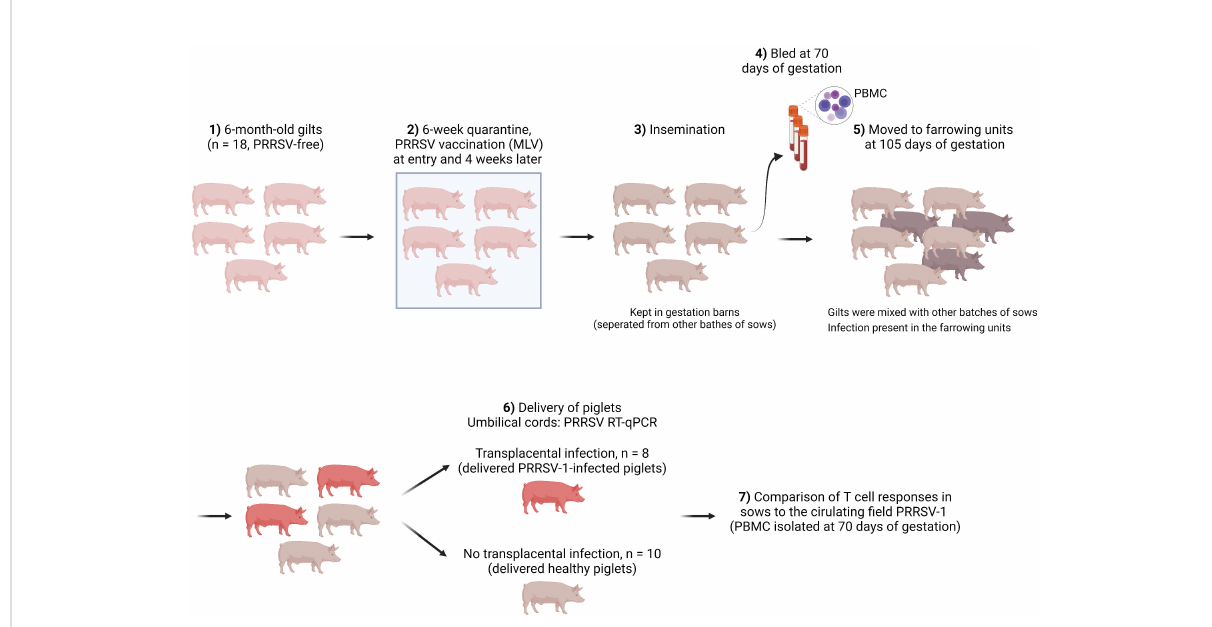
FIGURE 1 Schematic of gilt management, sampling, and determination of transplacental